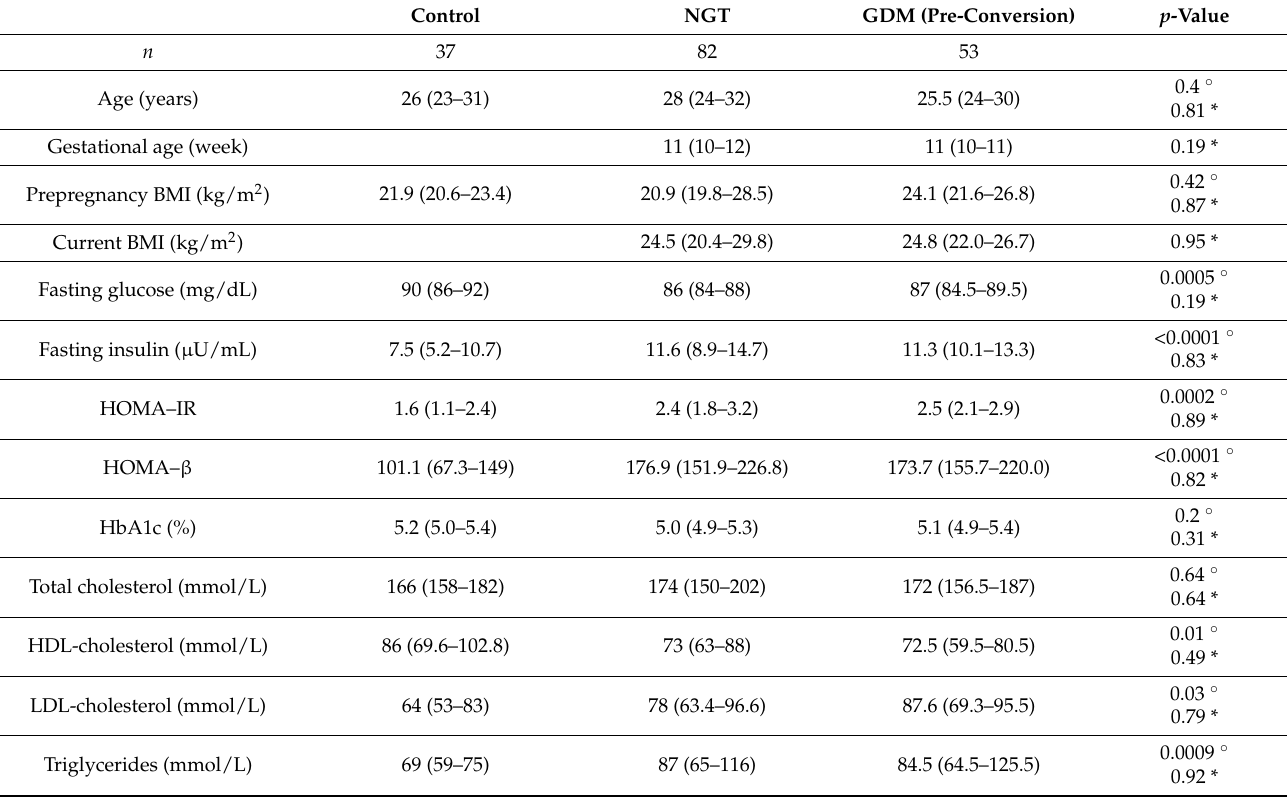
Table 1. Clinical characteristics of the groups studied in the 1st trimester.